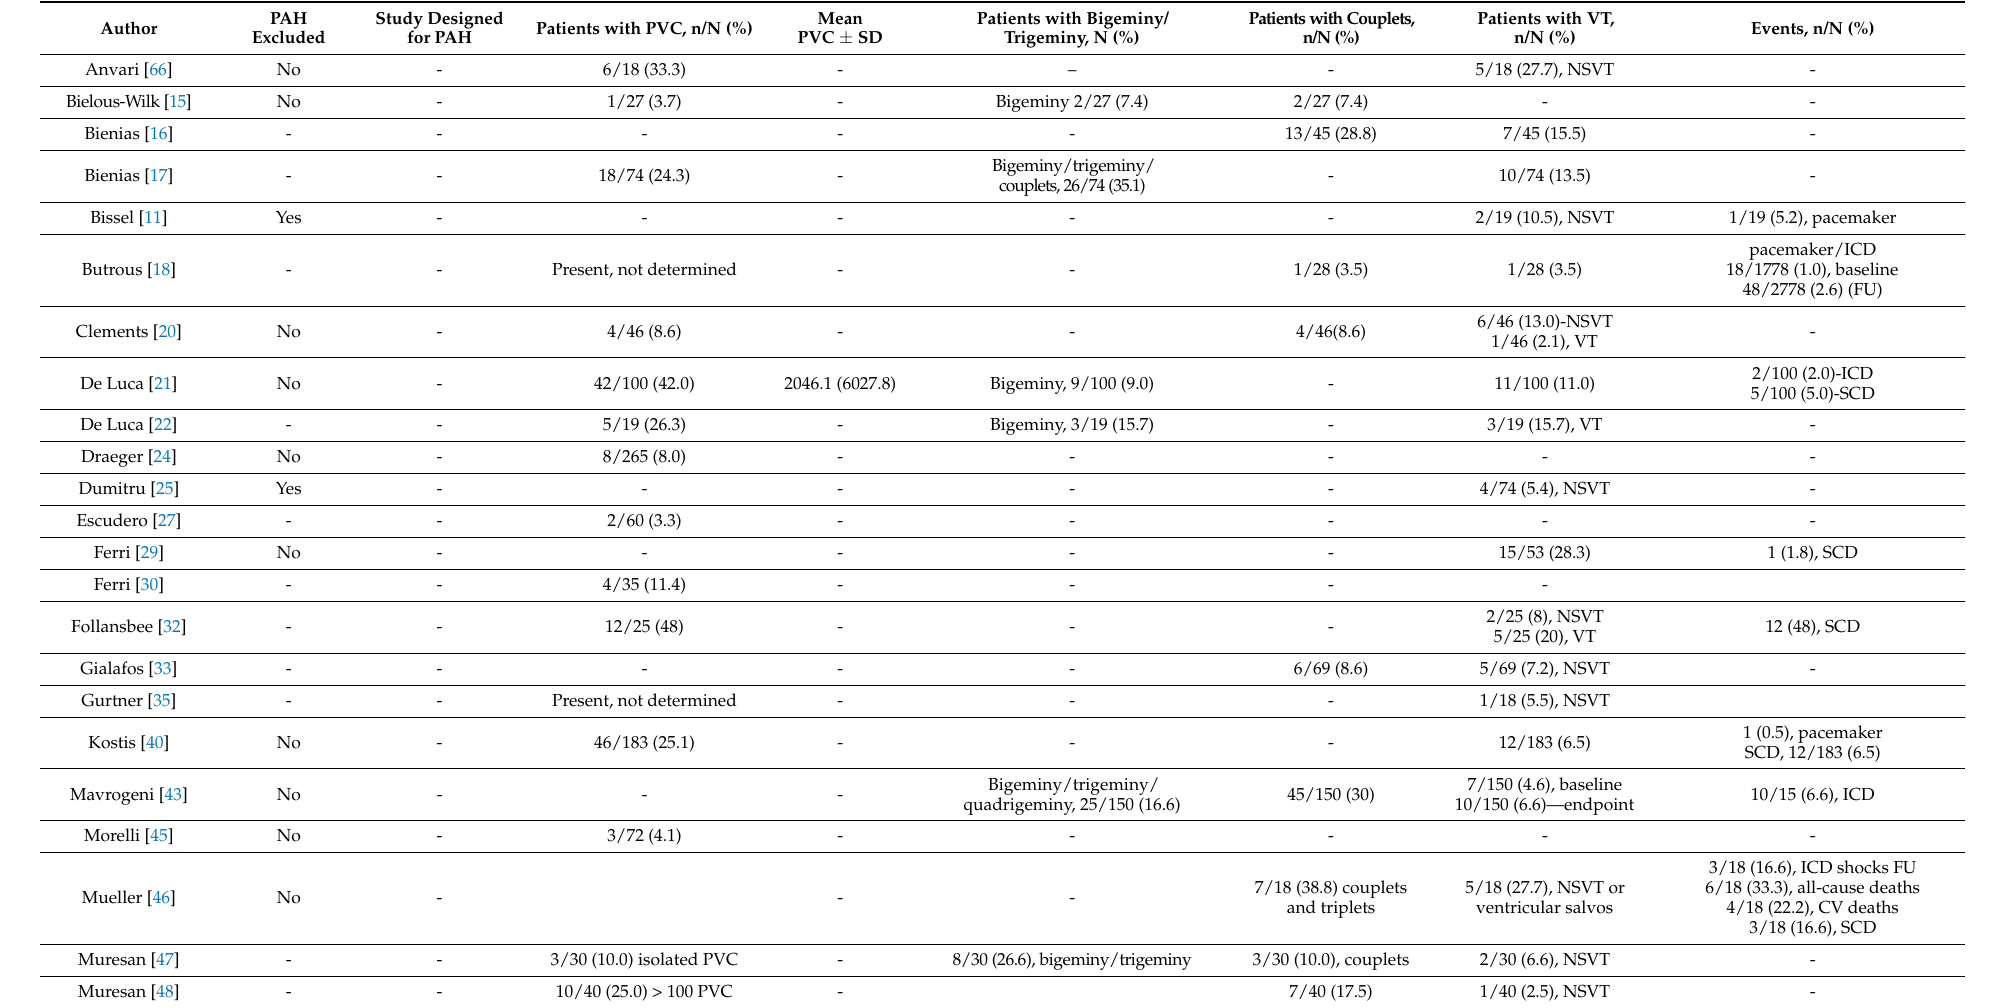
Table 4. Frequency of ventricular arrhythmias and cardiovascular events in SSc